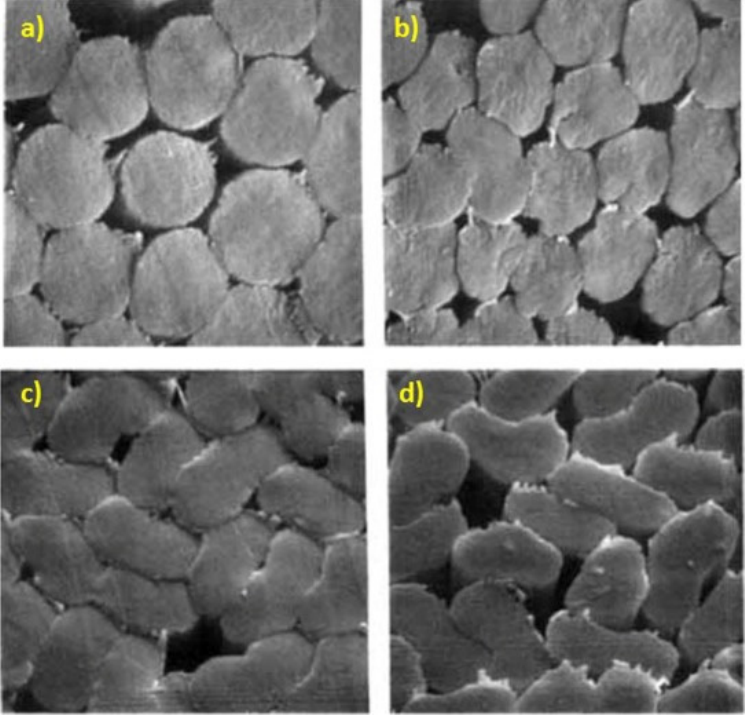
Figure 3. Effect of molecular weight on PAN cross-section, ( a ) 165,000, ( b ) 253,000, ( c ) 340,000, and ( d ) 429,000 g/mol ( × 1550) (reprinted with permission from [32]; copyright 1991 John Wiley and